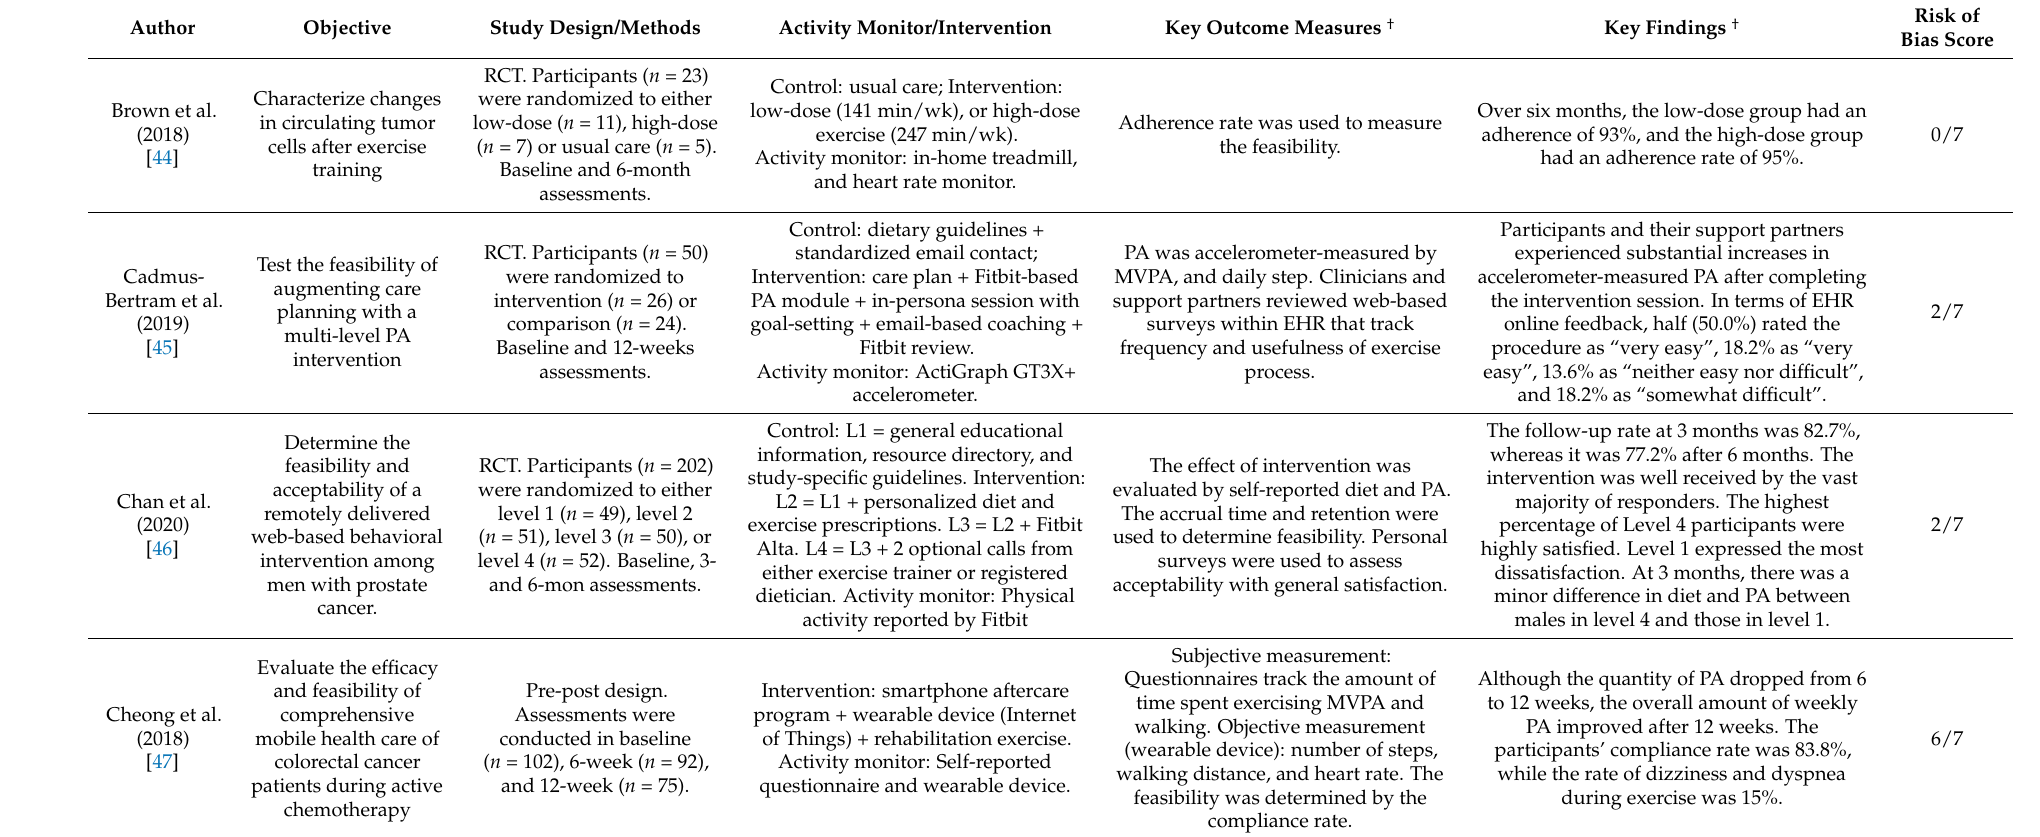
Table 2. Summary of articles included in the